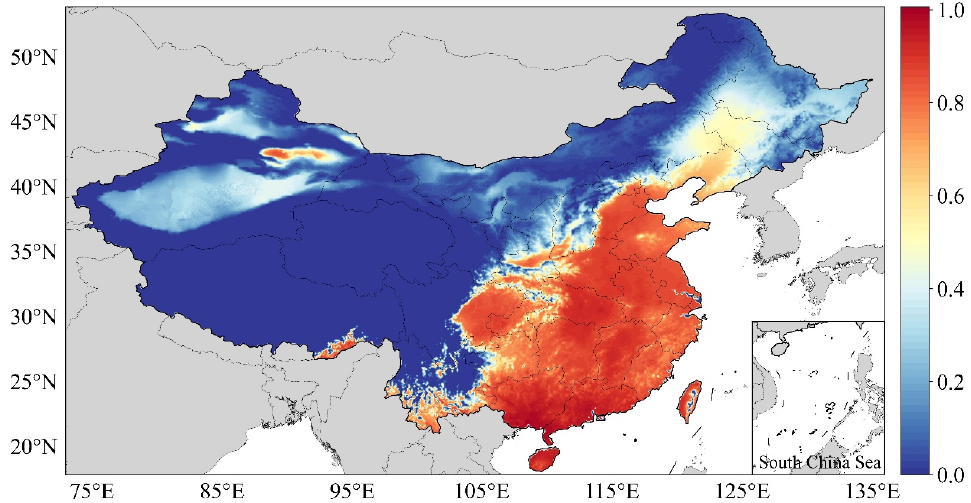
Figure 11. Heatwave hazard assessment. Data from Yin’s results [49].